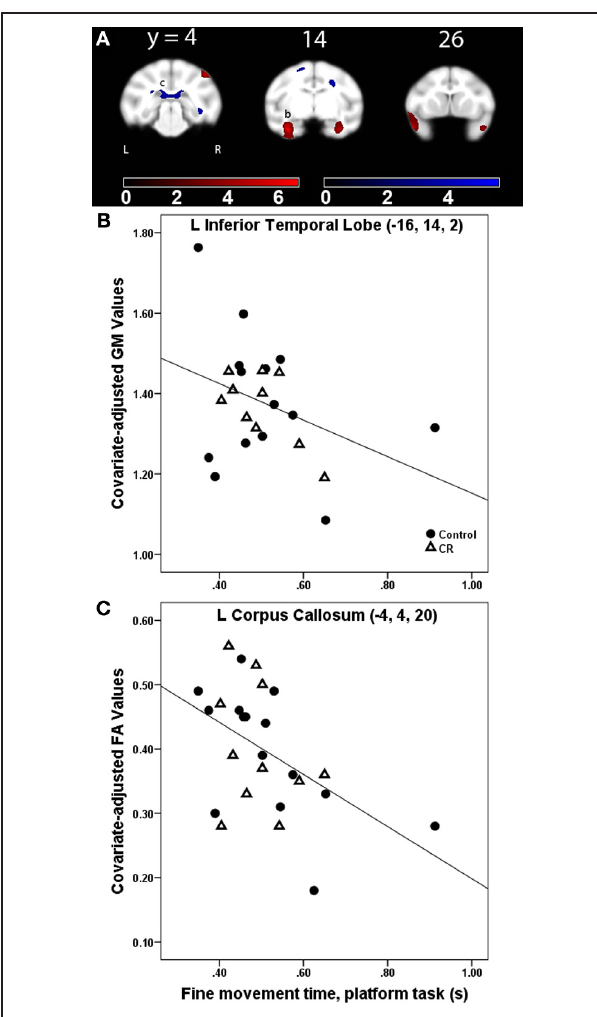
FIGURE 3 | (A) Statistical parametric map of the t -contrast displayed on coronal slices showing regions where greater fine movement time (in seconds) on the platform task was correlated to less gray matter (GM, red) and lower fractional anisotropy (FA, blue) values for all animals (controls and CR). All comparisons include age, gender, dietary condition, and global signal variable as covariates. The probability threshold for each t -contrast was p < 0 . 005 (uncorrected). The color bars represent the value of the t -statistic. The left side of the brain is on the left in the images. (B) Plot of the negative correlation between fine movement time (in seconds) on the platform task and regional GM at the labeled location in the inferior temporal lobe as (b) in panel (A) . (C) Plot of the correlation between higher fine movement time (in seconds) on the platform task and lower FA at the left corpus callosum, labeled as (c) in (A)